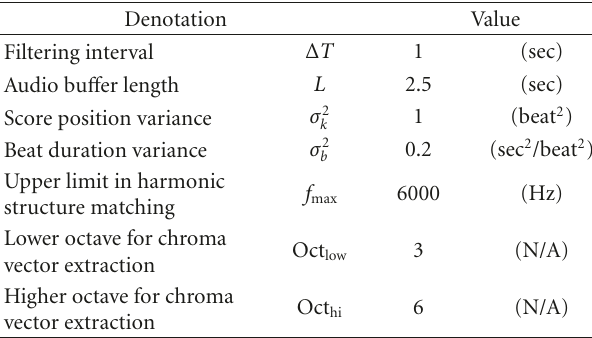
Table 1: Parameter settings.